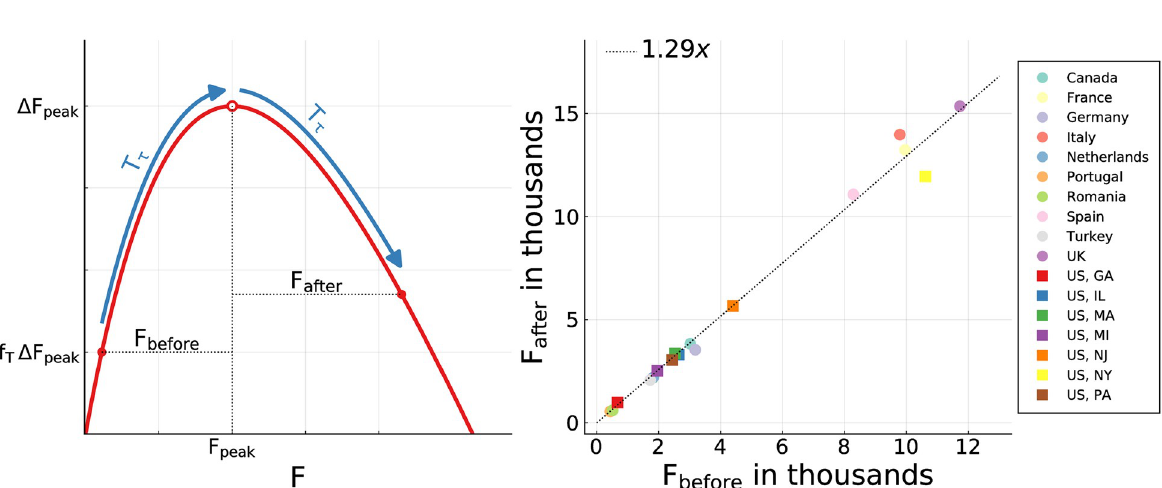
before/after the τ